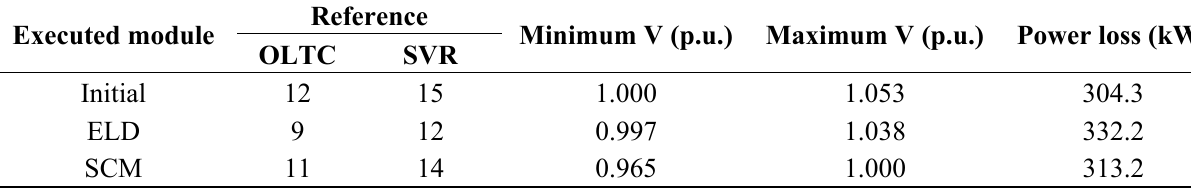
Table 7. Calculated references and corresponding network states for Case